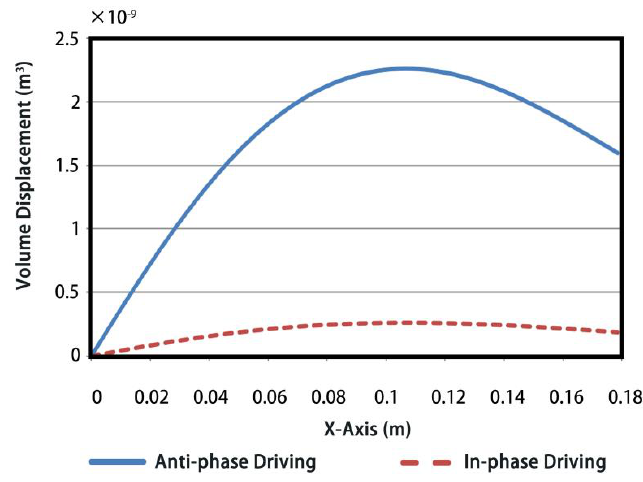
Figure 7. The volume displacements along semi-shell of transducer.